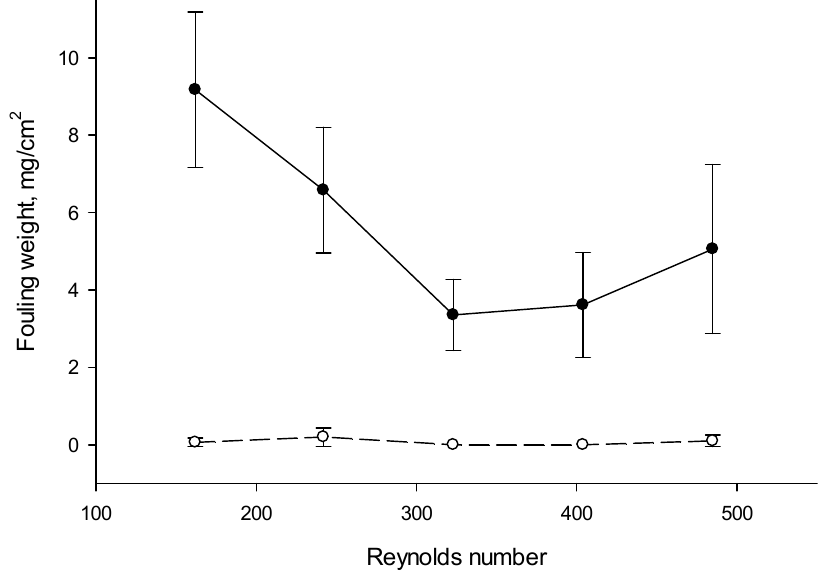
Figure 7. Weight of protein fouling (in mg/cm2) recovered on the BPM cationic interface in contact with milk after EDBM depending on the Reynolds numbers under CC and PEF current mode (PEF in dashed line and CC in solid line). Reynolds numbers of 162, 242, 323, 404 and 485 correspond to flow rates of 400, 600, 800, 1000 and 1200 mL/min respectively. CC—constant current and PEF—pulsed electric field.